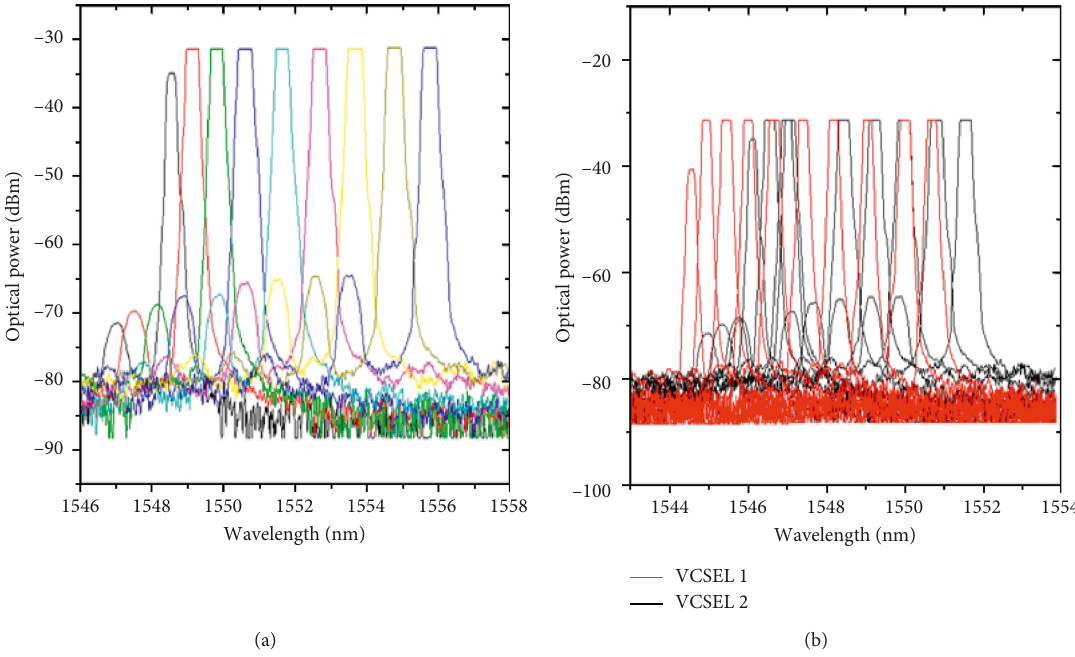
Figure 4: (a) Channel switching and (b) band overlap of VCSEL as a function of wavelength tunability [33].